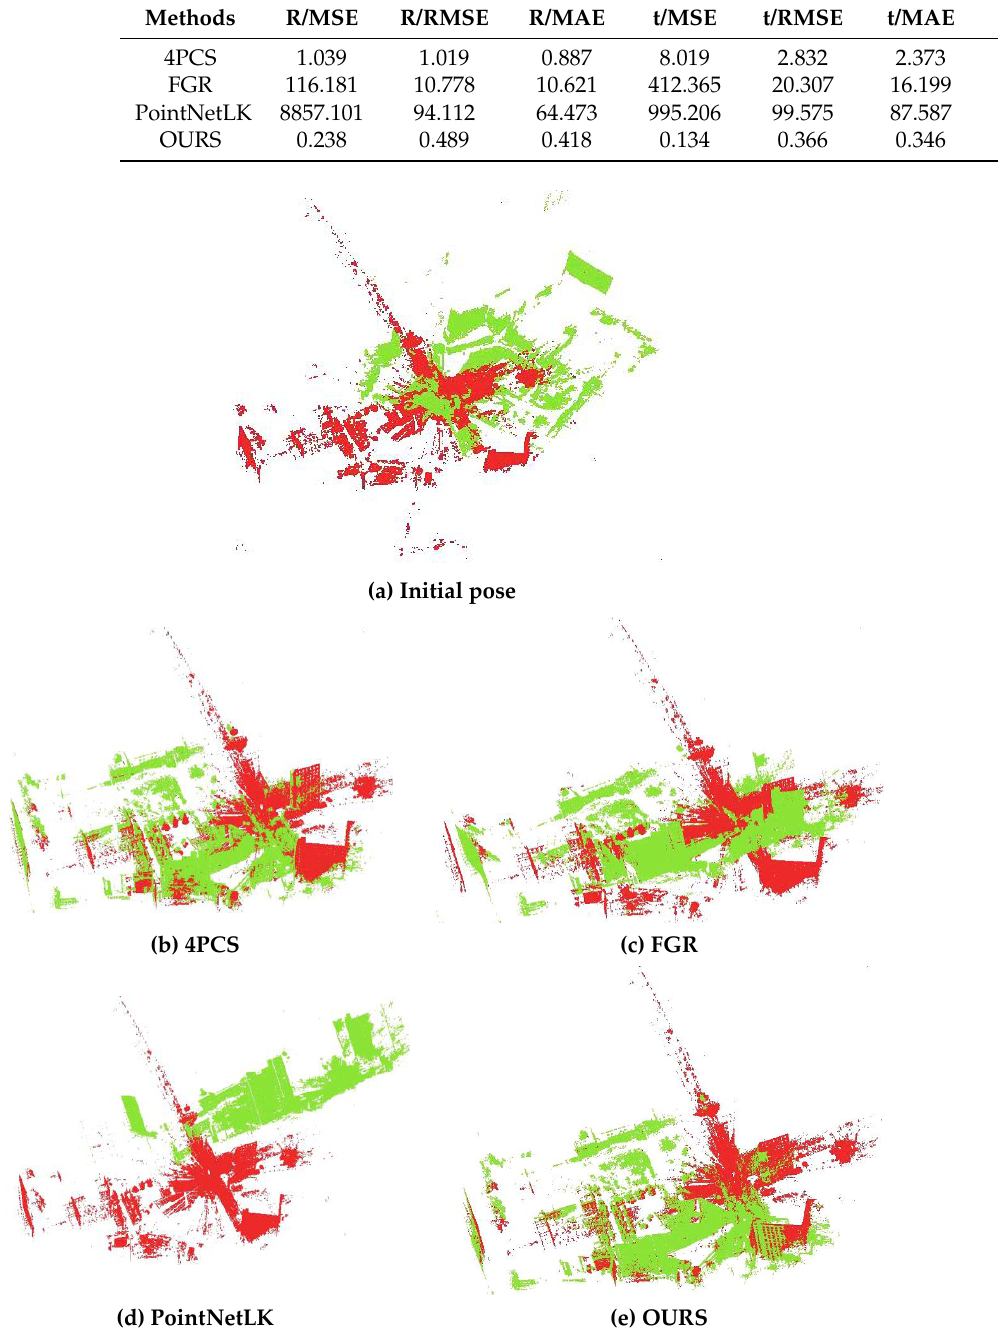
Figure 5. Registration results of each algorithm for campus scenes.